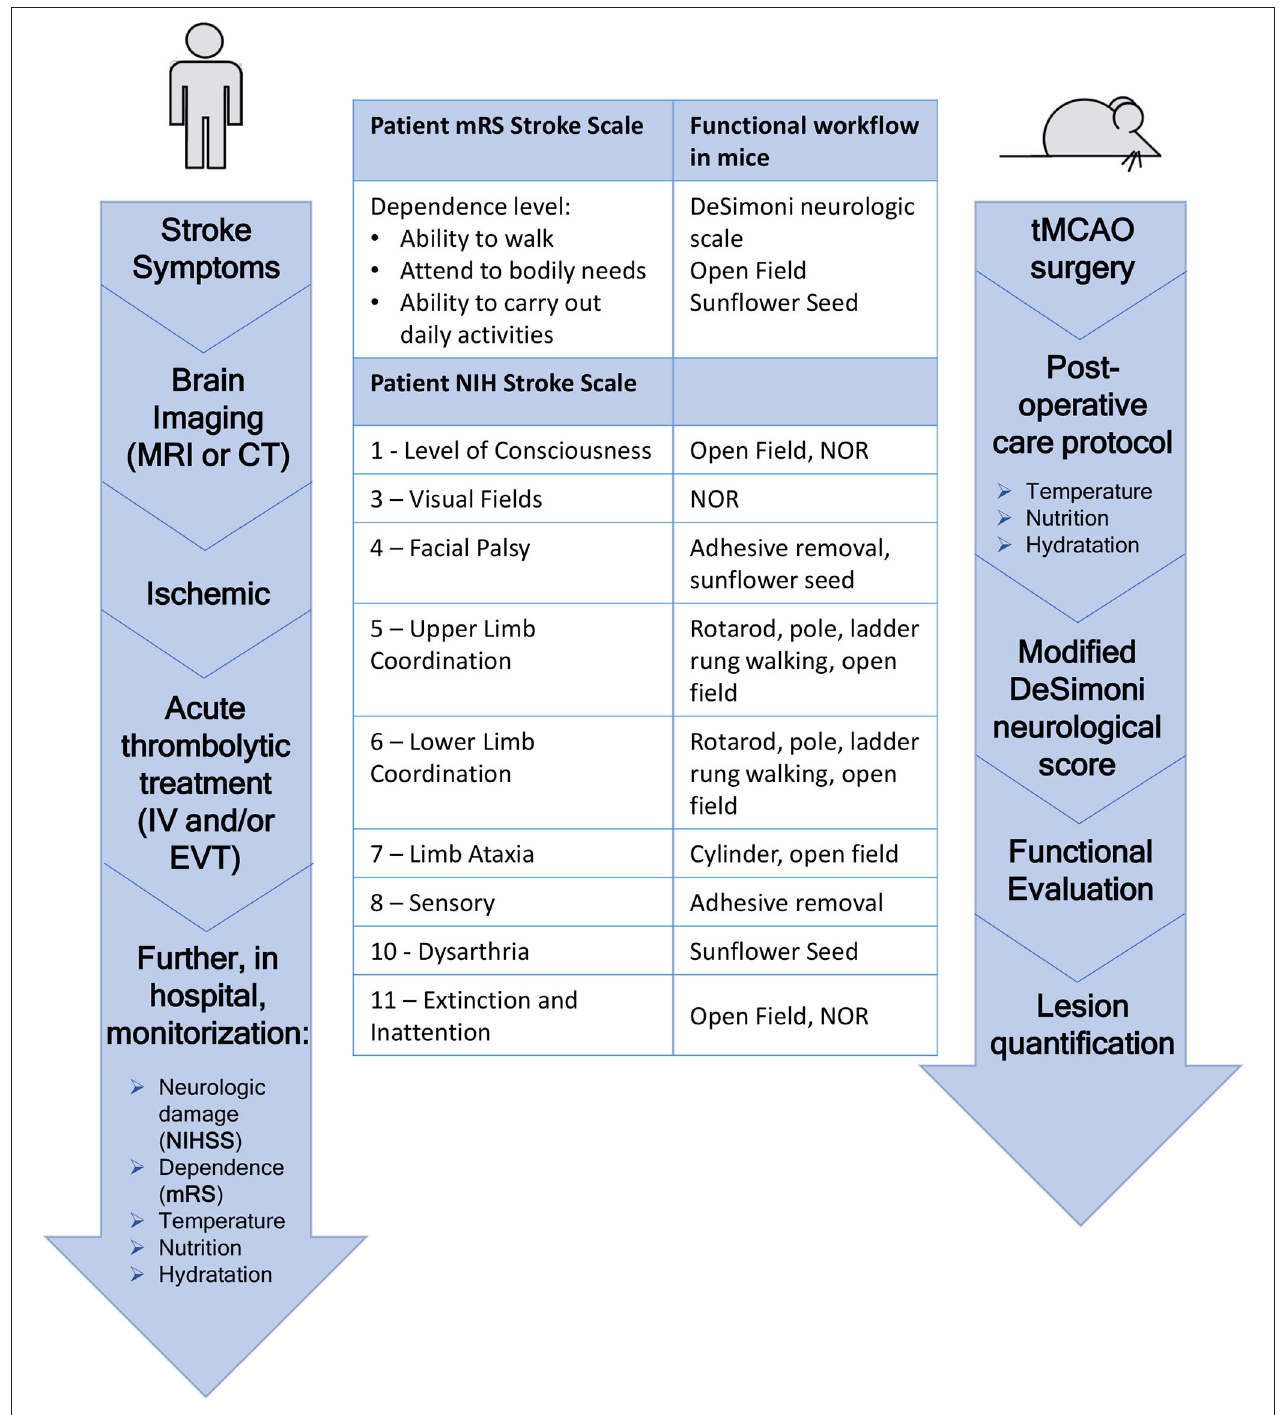
FIGURE 6 | Flowchart of patient treatment of stroke symptoms compared to the flowchart of the timeline followed in this mouse stroke model. Direct correlation between several tasks of the patient’s NIH stroke scale and the tests compromised in the behavior workflow can be